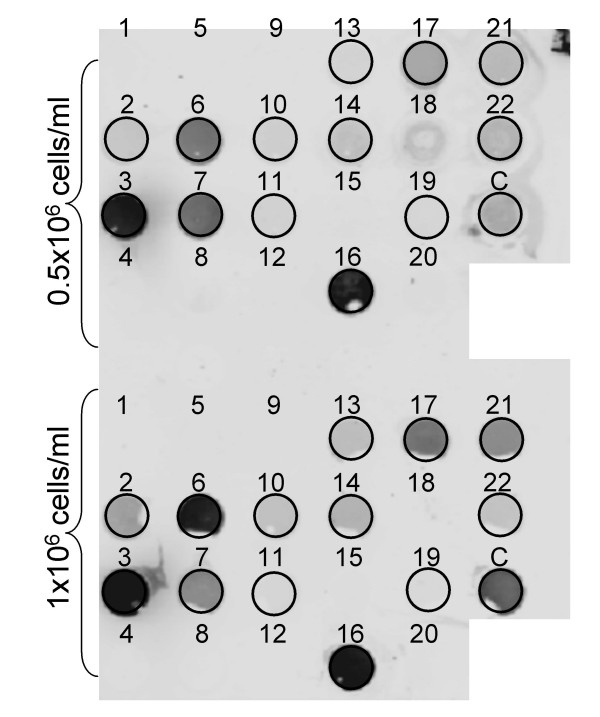
Screening expression yield of 24 well cultures by dot blot. Supernatants from 2 ml 24 well blocks transient transfections were analysed by Cy5 dot blot using denaturing conditions of 5 M urea. The top half of the blot represents supernatants from cells seeded at 5 × 105 cells/ml and the bottom half of the blot represents supernatants from cells seeded at 1 × 106 cells/ml. Dots showing secretion positive hits are indicated by a circle (14 positive hits and 9 failures). Those dots corresponding to successful purification hits from large scale transient transfections are shown by a square box around the vector number. The signal intensity of the dots is shown in table 2. The control protein C was rCD4 (domains 3 + 4)-His10 expressed from vector C, Figure 1.